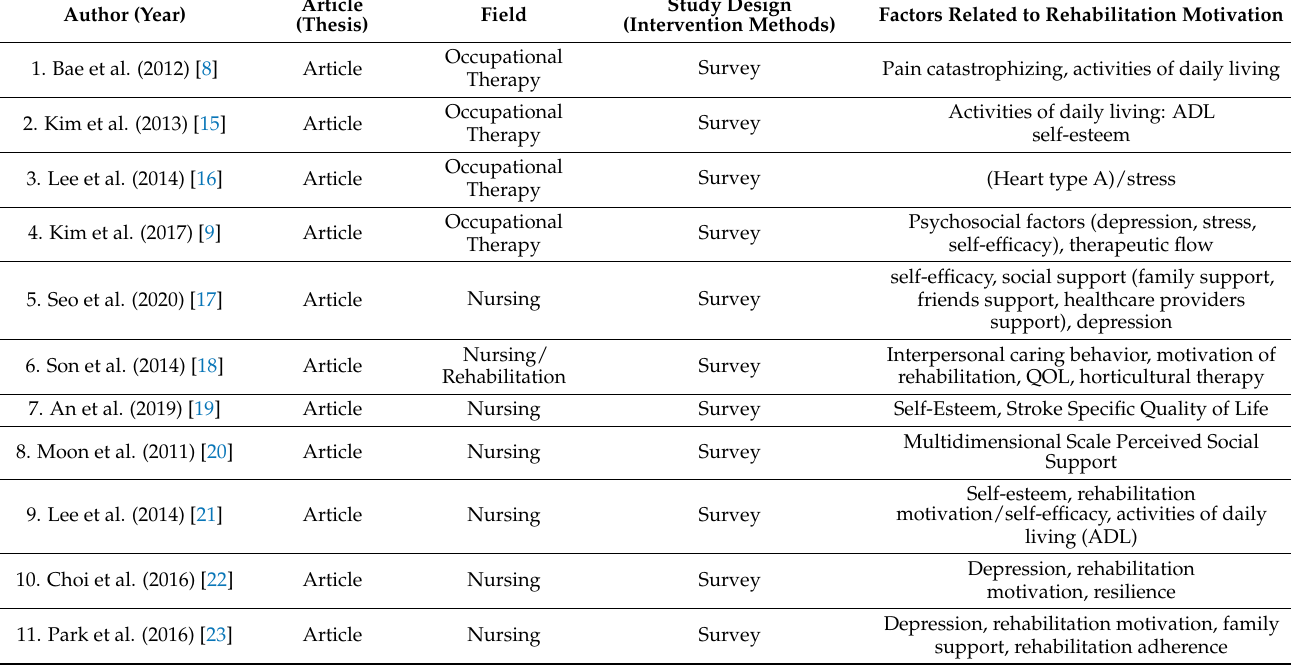
Table 1. Characteristics of the studies included in the scoping